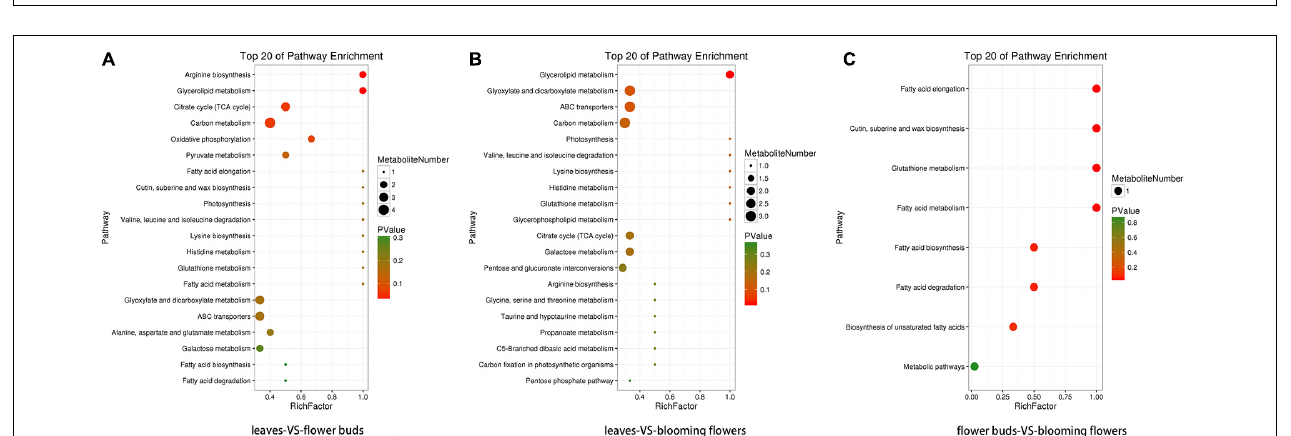
FIGURE 10 | KEGG pathway annotation of metabolites.